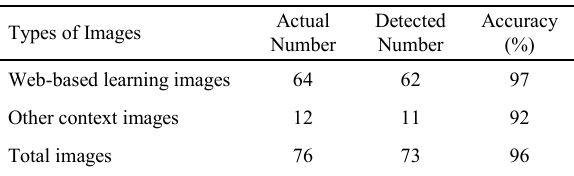
Table 1. The results of feature matching for a wearable context recognition system